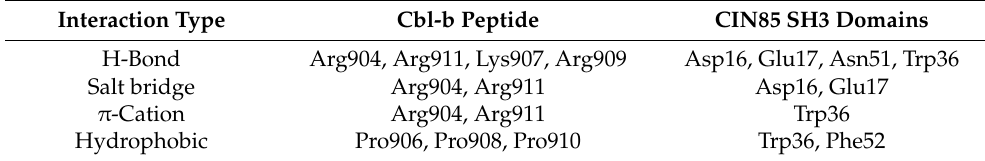
Table 1. Residues of Cbl-b protein and CIN85 SH3 domains involved in